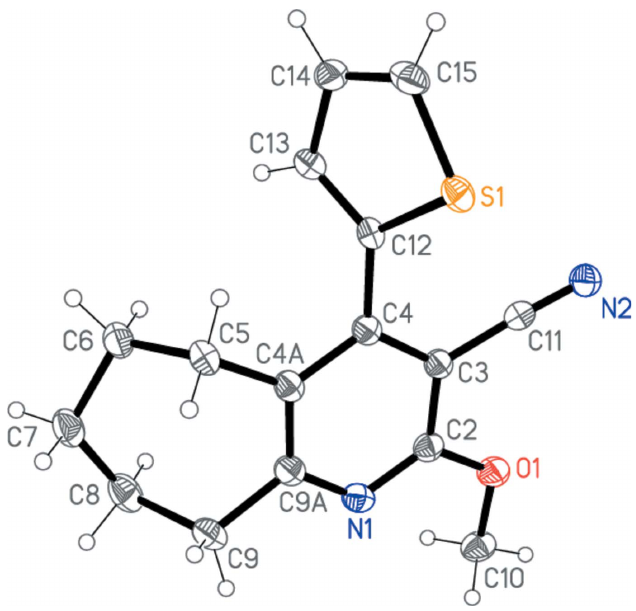
Figure 2 The molecule of 1b in the crystal. Ellipsoids represent 50% probability